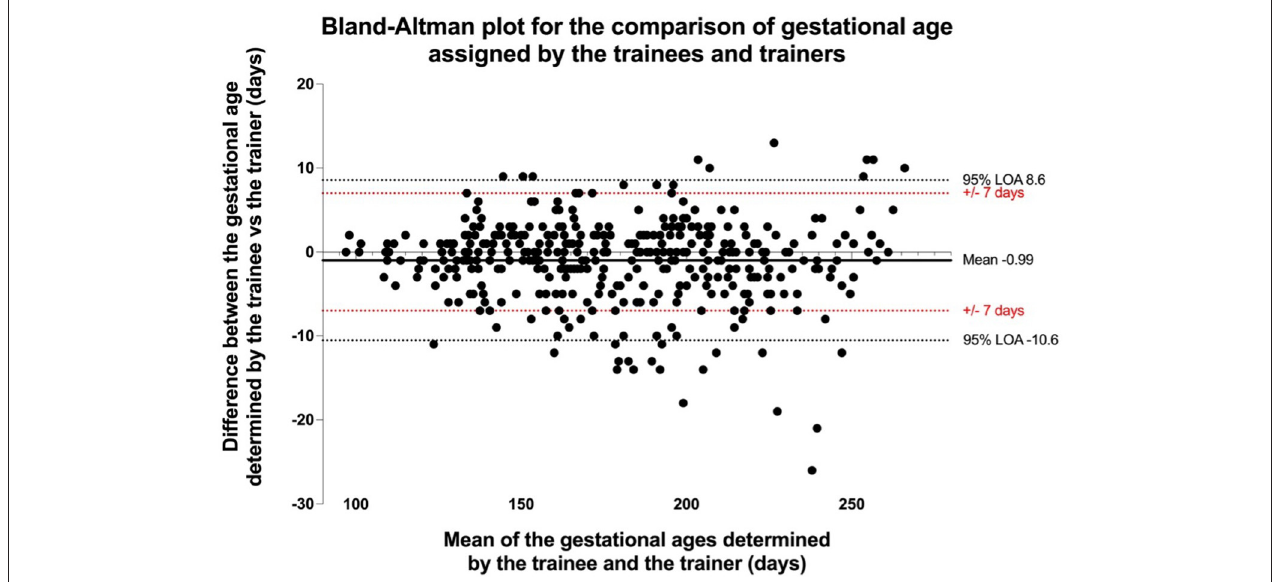
FIGURE 2 | Bland Altman plot of comparison between the gestational ages assigned by the trainees vs the